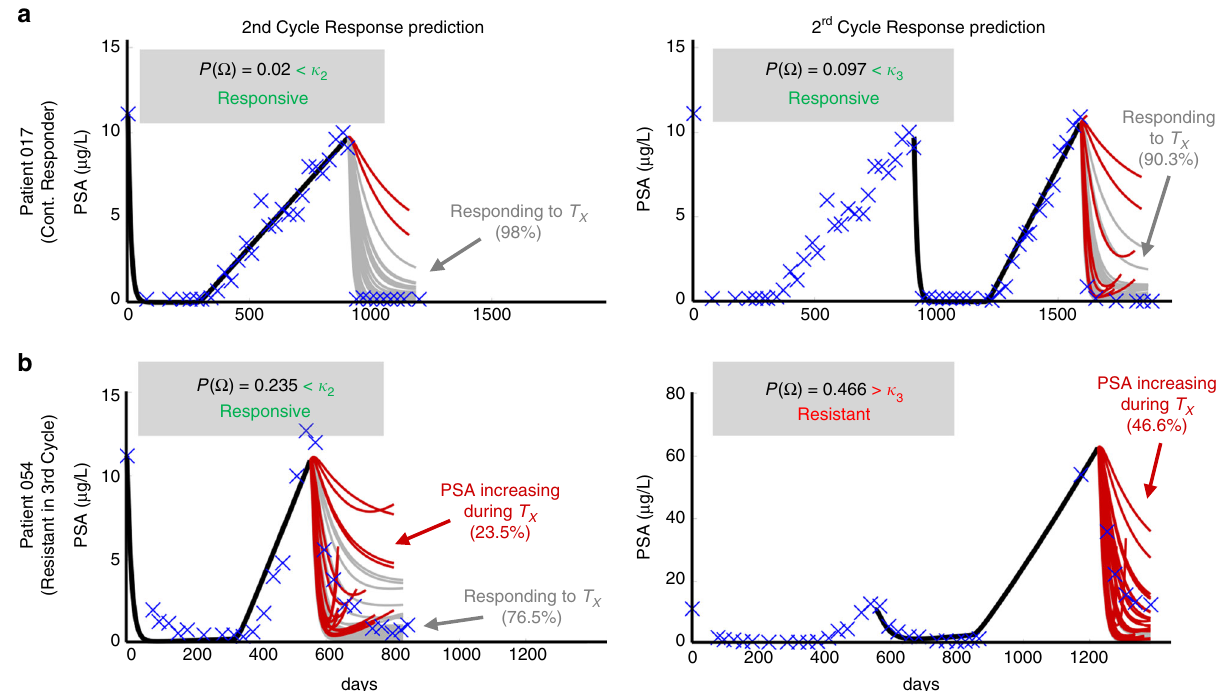
Fig. 3 Model forecast using parameters obtained by sampling from CDF and 95% con fi dence intervals. a The model predicted responsiveness in cycles two (98% of simulations) and three (90.3% of simulations) for Patient 017. The probability of resistant P ð Ω Þð Þ was less than its respective κ κ ¼ 0 : 45 ; κ ¼ 0 : 29 ð Þ for each cycle. The patient completed the trial on day = 2202. b The model predicted resistance in 23.5% of cycle 2 simulations 2 3 and in 46.6% of cycle 3 simulations for Patient 054. The predicted probability of resistance in cycle three was greater than κ 3 so the patient would be advised to stop the trial. Data showed that he became resistant on day 1384 during the third cycle, as predicted.